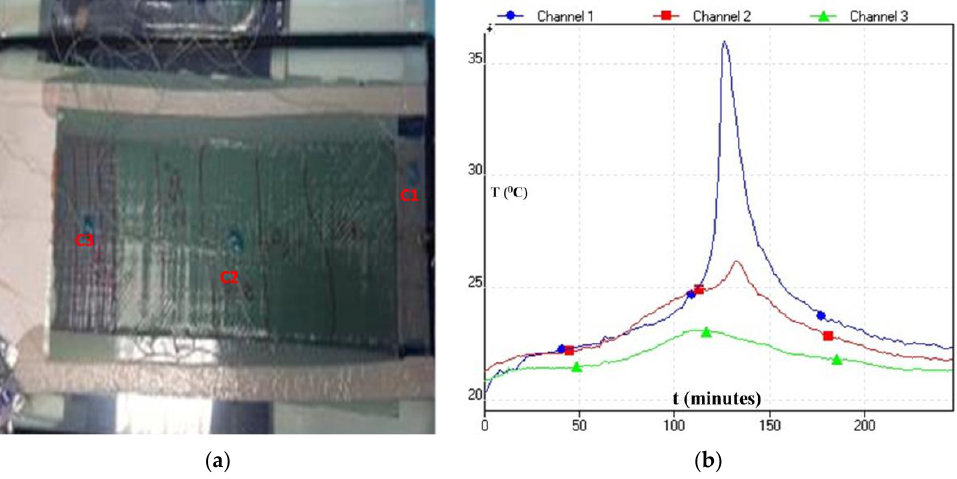
Figure 5. Thermoplastic resin infusion set-up showing ( a ) mounted thermocouples ( b ) t-T curve recorded during the infusion.